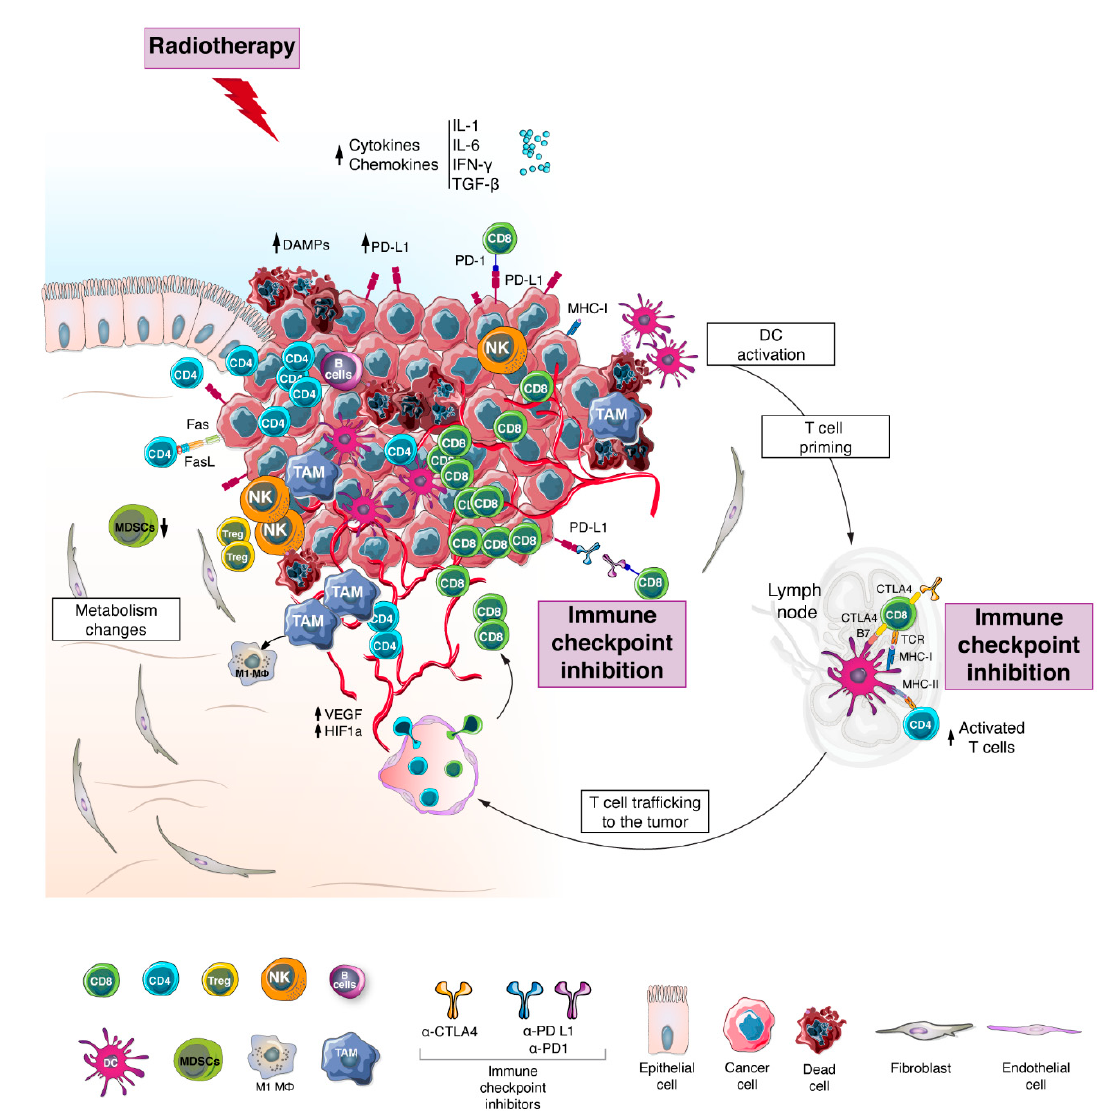
Figure 2. Tumor microenvironment after radiotherapy and immune checkpoint Inhibition. Upon radiotherapy, cancer cells undergo immunogenic cell death that is associated with the release of damage associated molecular patterns (DAMPs), neoantigens and pro-inflammatory cytokines (e.g., IFN- γ , IL-1 and IL-6), which promote the expression of immunomodulatory genes including antigen presentation genes and lead to the recruitment and activation of dendritic cells (DCs). Following migration to the lymph node, DCs are involved in priming and activation of T lymphocytes, which are then recruited into the tumor site alongside other immune cells. Additional modifications in the tumor microenvironment (TME) upon radiotherapy (RT) treatment include shift in macrophage phenotype towards M1, modulation of the tumor vasculature and alteration of the cell metabolism. Altogether these events enhance the recognition and killing of tumor cells. Besides inducing de novo inflammation, RT is also responsible for increasing the expression of immune checkpoints such as PD1, PD-L1 and CTLA-4. In this context, the application of immune checkpoint inhibitors might further add to the ongoing adaptive anti-tumor immunity. Taken together, the effect of RT on the TME could evoke the transition from CMS2-like TME to CMS1-like TME.